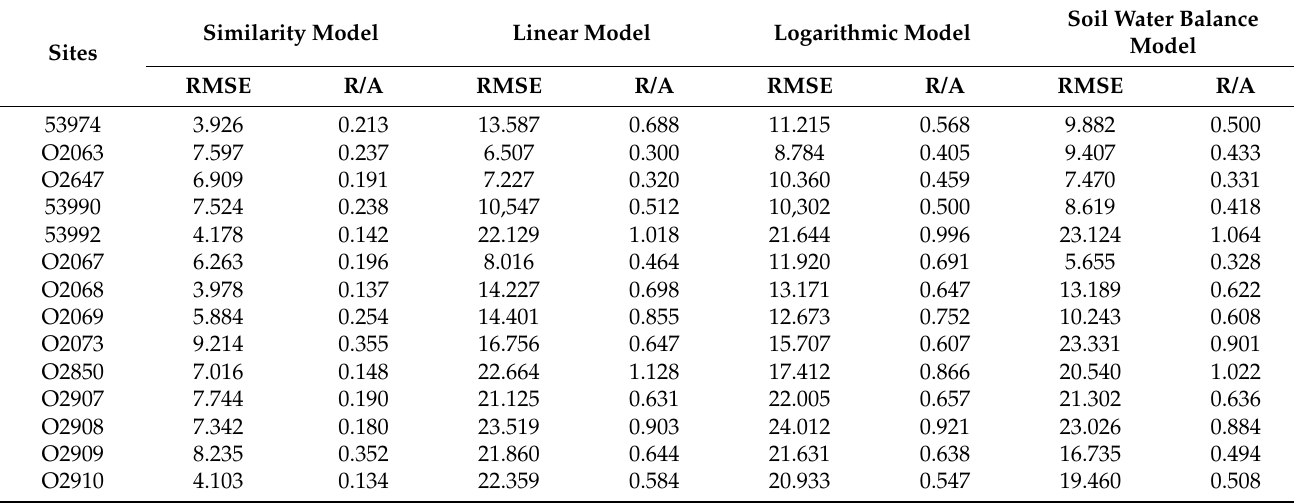
Table 5. Calculation results of relevant indicators of each site